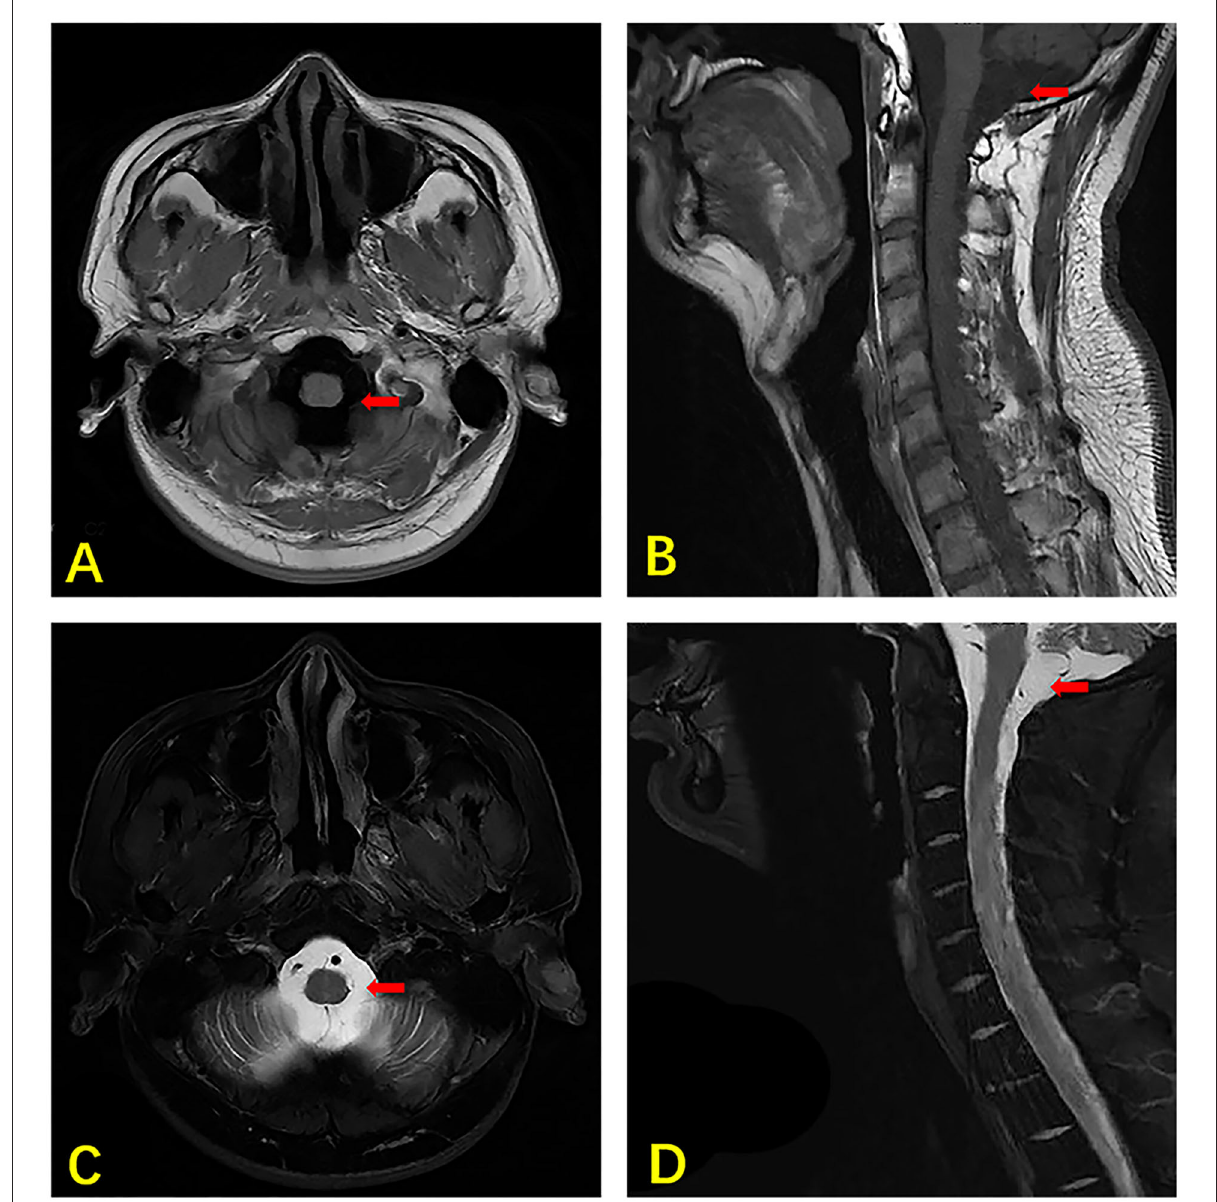
FIGURE1 MRI of the brain and cervical vertebra of our case. The axial section T1 weighted image showing hydrocephalus (arrow) (A) . The sagittal section T1 weighted image showing hydrocephalus (arrow) (B) . The axial section T2 weighted image shows hydrocephalus (arrow) (C) . The sagittal section T2 weighted image showing hydrocephalus (arrow) (D)